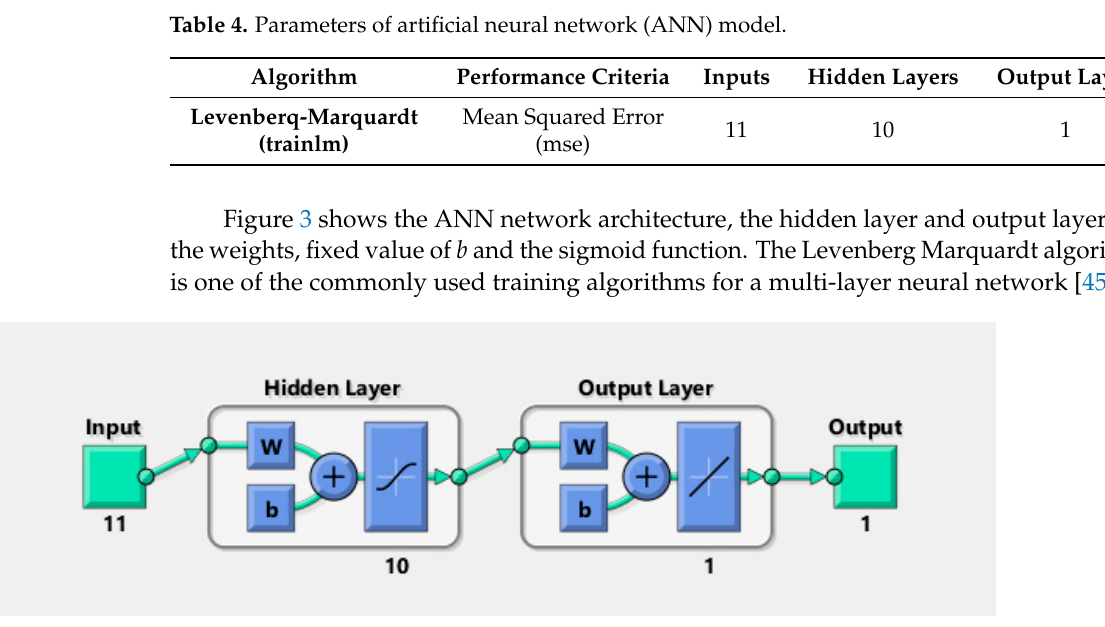
Figure 3. ANN network architecture for data modelling (11–10–1–1).